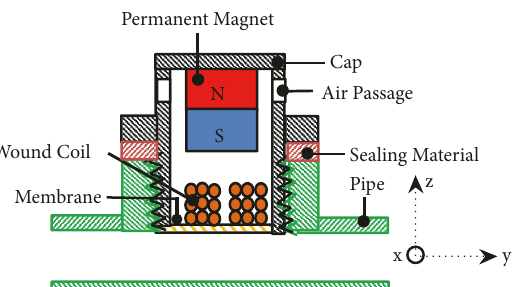
Figure 3: Cross-sectional view of EMEH for pipeline monitoring system.